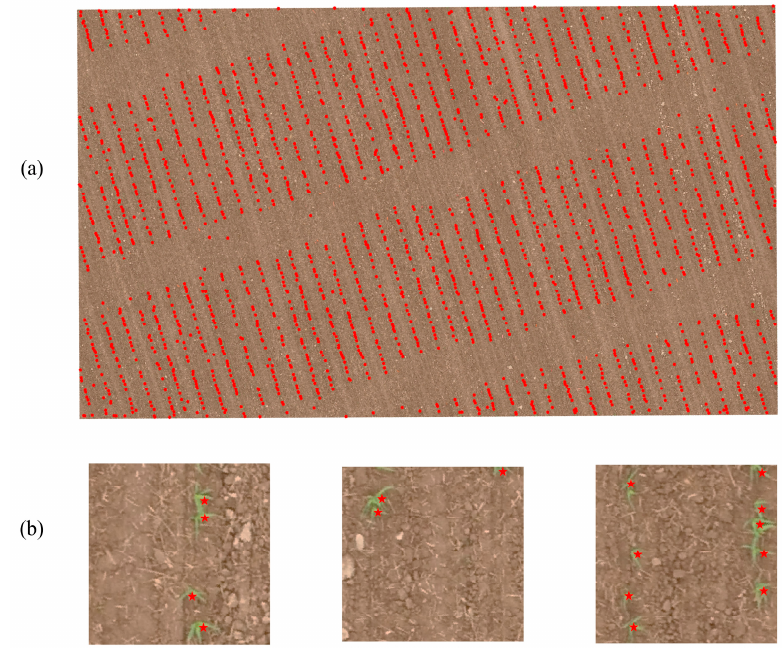
Figure 10. ( a ) Detected plants in the first image: ( b ) Instances of the extracted image patches. Red stars are the centers of predicted plants according to the object detector.